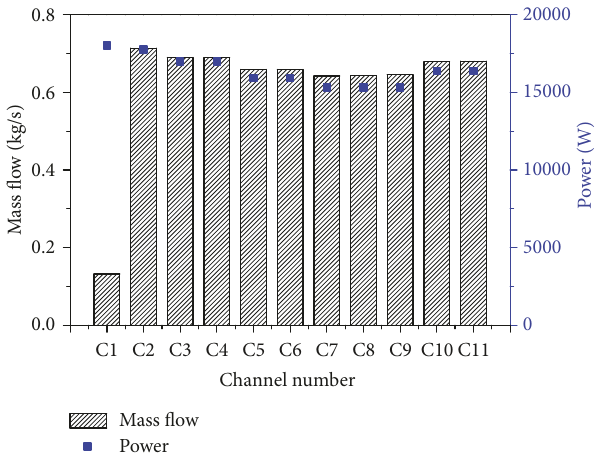
Figure 13: The mass flow and power in each fuel